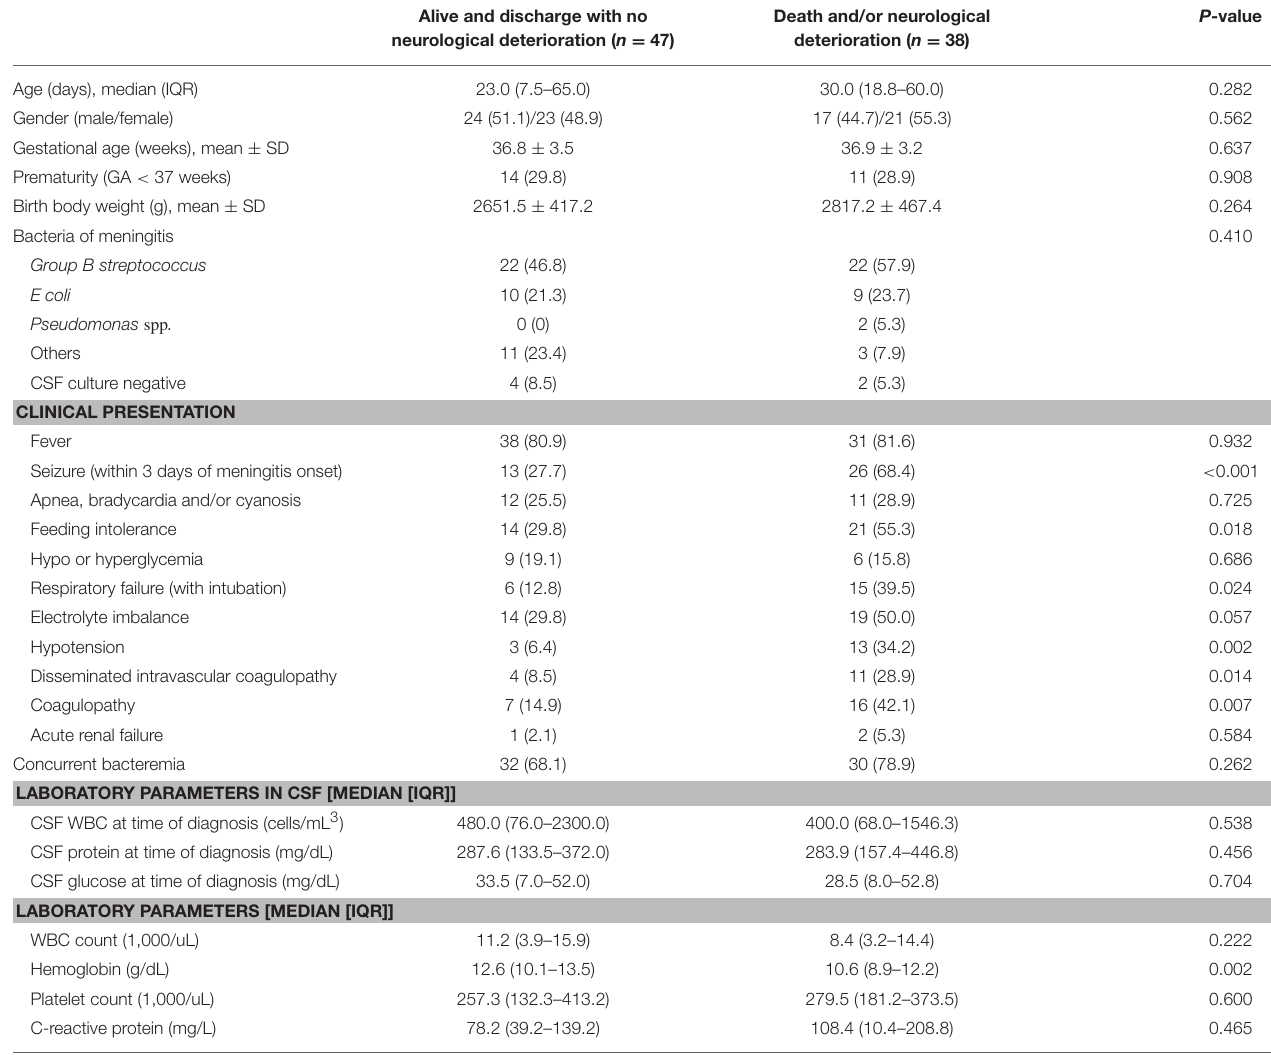
TABLE 1 | Epidemiological factors, co-morbid conditions, clinical data and laboratory parameters.